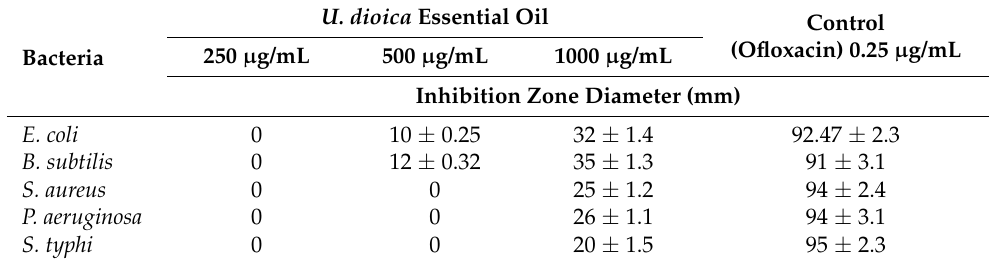
Table 4. Antibacterial activity of Urtica dioica essential oil against selected bacteria strains.